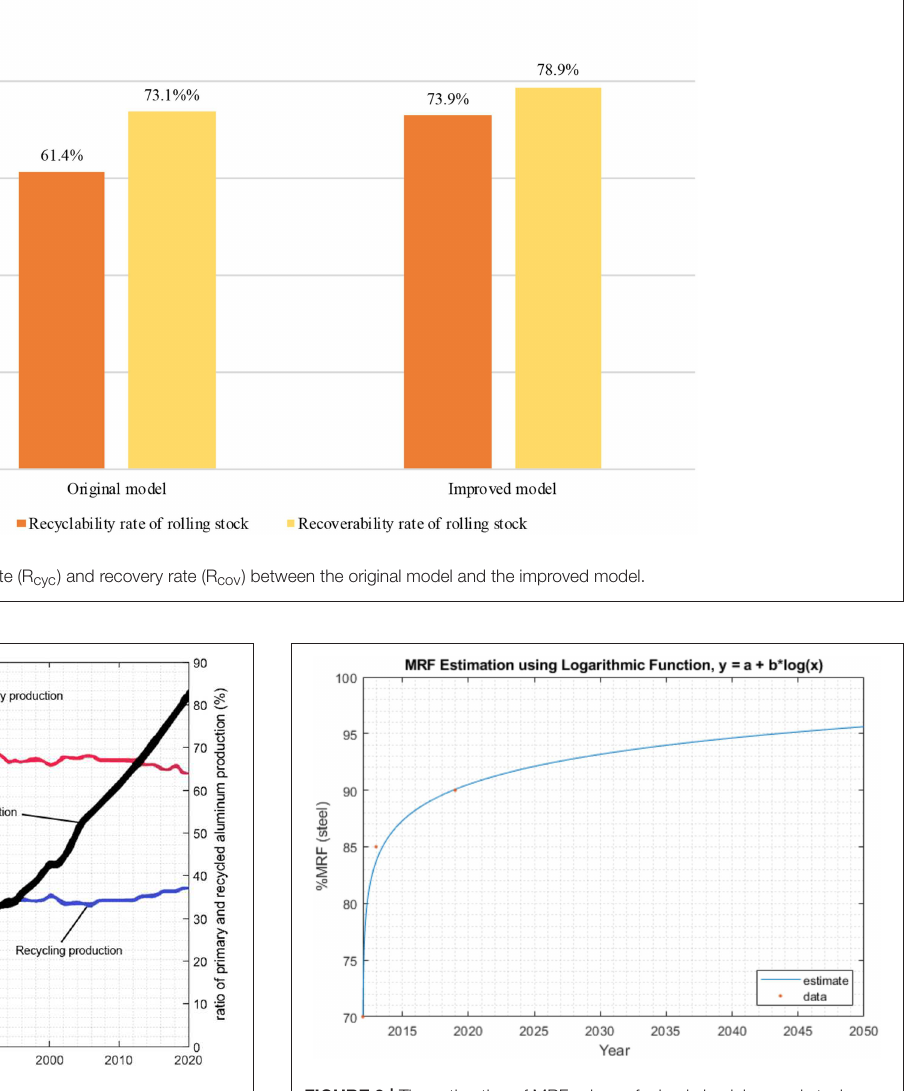
FIGURE 2 | The percentage of recycling component in aluminium production (adapted from Greem, 2007).